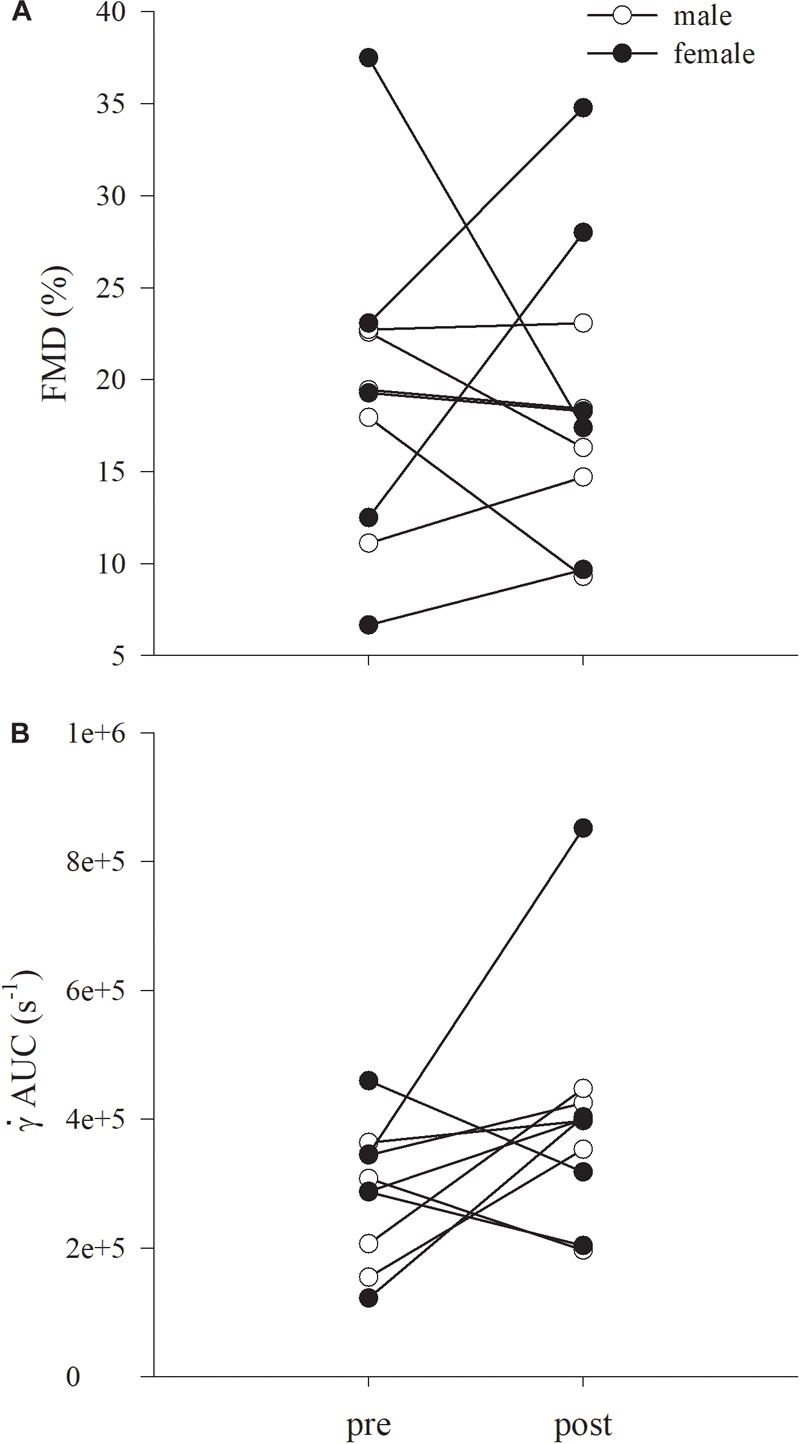
Individual data for brachial artery flow mediated dilatation (FMD) (A) and cumulative shear expressed as AUC ( AUC B), are shown. Males and females are represented in open and closed circles, respectively. Data are presented as mean ± SD.